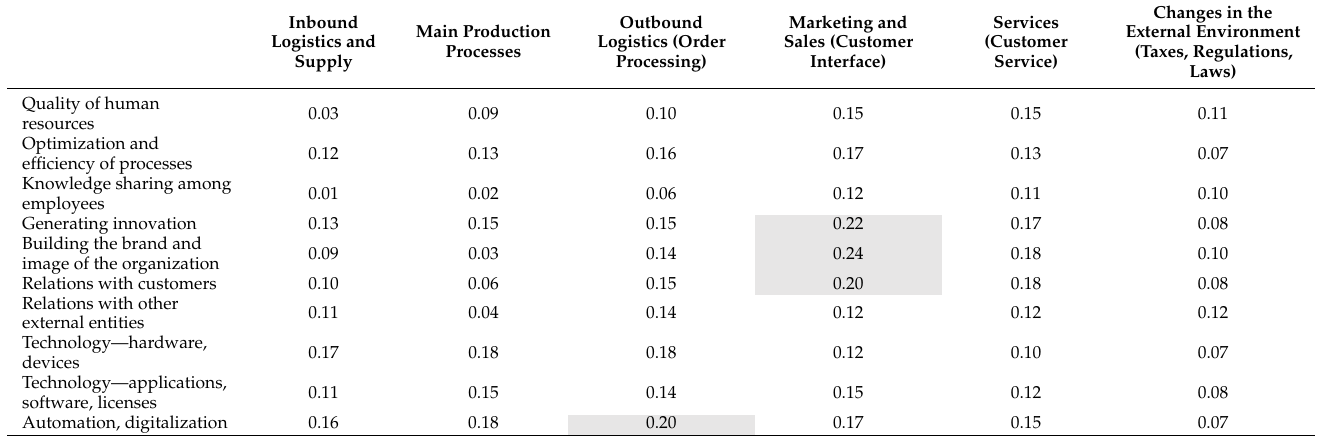
Table 3. Correlation analysis of value chain model areas and conducted activity in primary